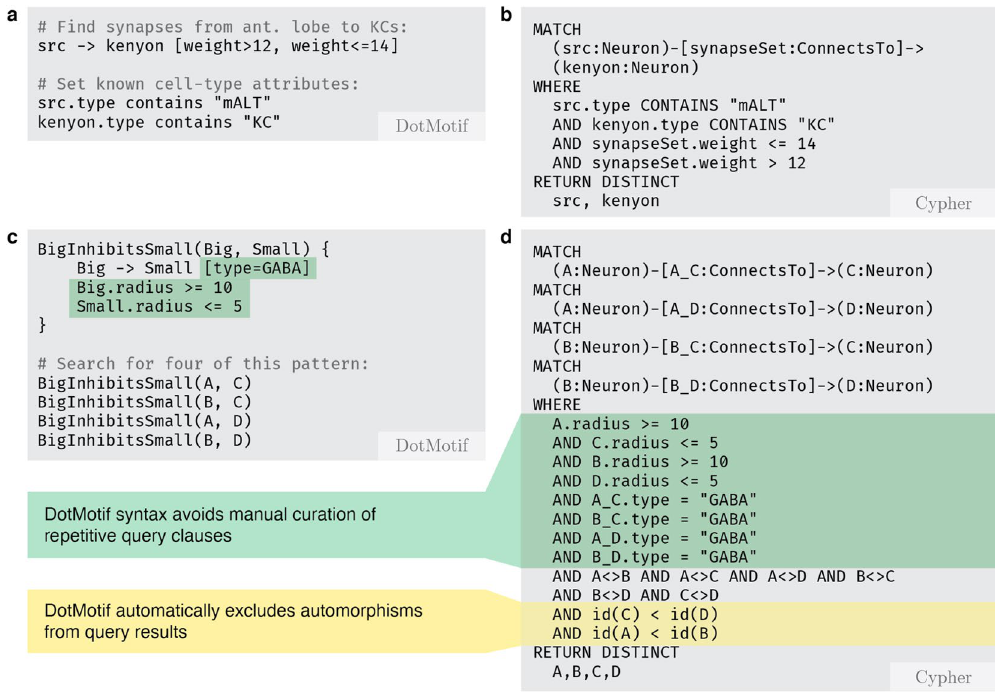
Figure 2. A comparison of DotMotif query syntax and the equivalent queries when transpiled to Cypher using the Neo4jExecutor. ( a ) A simple query to find inputs to Kenyon cells ( KC) from the medial antennal lobe tracts ( mALT ) in the Hemibrain dataset. Note that DotMotif comments are notated with the hash character. ( b ) The equivalent query as panel ( a ), when converted to the Cypher query language for use with neuPrint systems. Even in a small query such as this, DotMotif syntax tends to be more succinct and readable. ( c ) A simple DotMotif query for a repeated pattern with node and edge constraints. The motif includes a macro called BigInhibitsSmall, which establishes a connection between two neurons with a type edge-attribute of “GABA”, and with radius nodes attribute constraints on both neuron participants. This macro is reused multiple times in the final